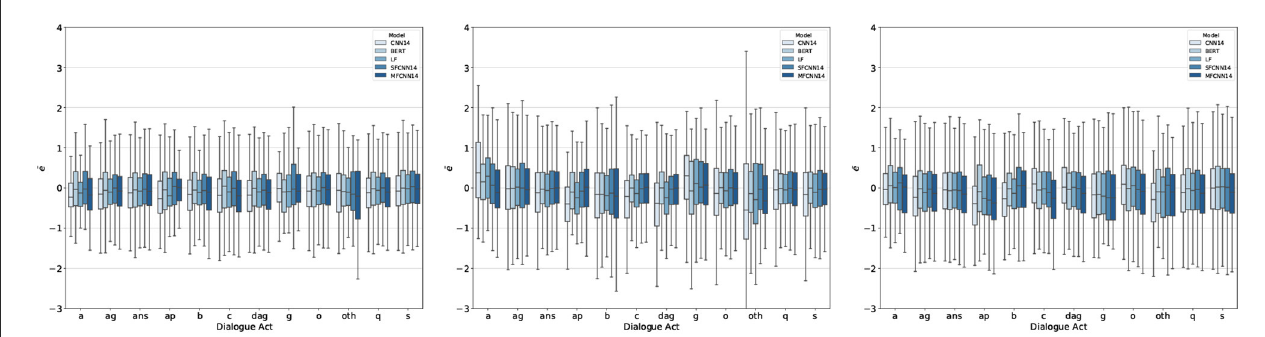
FIGURE5 Box plots showing the distribution of error residuals ( ¯ e = P N 1 e n = P N 1 y n t − y n p ) for emotional dimension prediction on IEMOCAP for (left to right) CNN14, BERT, LF, SFCNN14, and MFCNN14. Error residuals show if models are consistently under- ( e n > 0) or over-predicting ( e n < 0) the respective dimension for specific dialogue acts. Dialogue act taxonomy comprises of: acknowledgment (a), agreement (ag), answer (ans), apology (ap), backchanneling (b), command (c), disagreement (d), greeting (g), opinion (o), question (q), statement (non-opinion) (s), and other